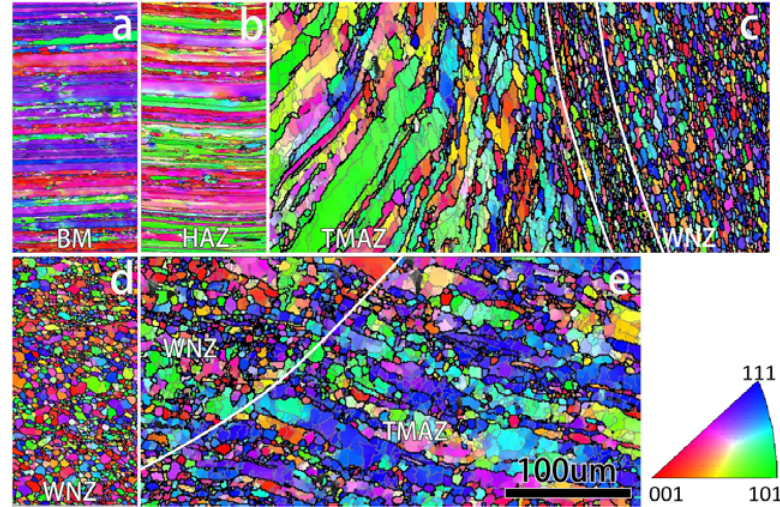
Figure 5. Electron back ‐ scattered diffraction (EBSD) orientation map of grains in different zones in a FSW joint of 7A52 alloy: ( a ) base metal; ( b ) HAZ with the lowest hardness on the advancing side; ( c ) thermo ‐ mechanically affected zone (TMAZ) on the advancing side; ( d ) weld nugget; ( e ) TMAZ on the retreating side.